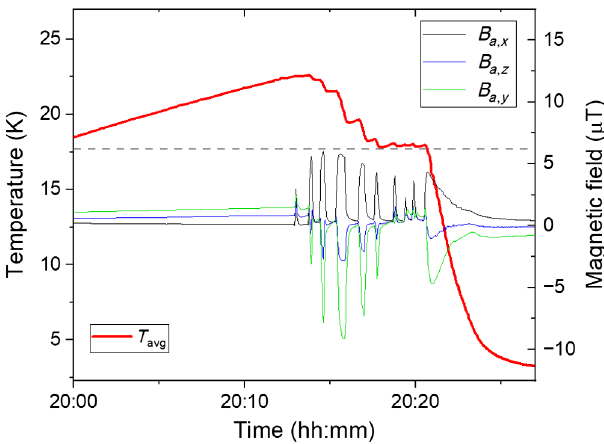
FIG. 24. T and B along three orthogonal directions at the a avg cavity equator during the second cooldown for which the CCRs ∼ 17 . 7 were power cycled on and off. The dashed line is at T c